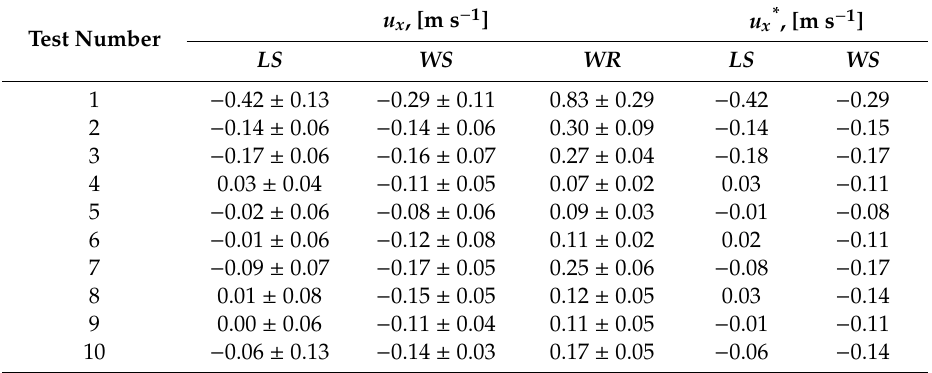
Table 3. Average values of the u x component of the air velocity perpendicular to the greenhouse vents and the corrected u x* . LS , leeward side vent; WS , windward side vent; WR , windward roof vent.